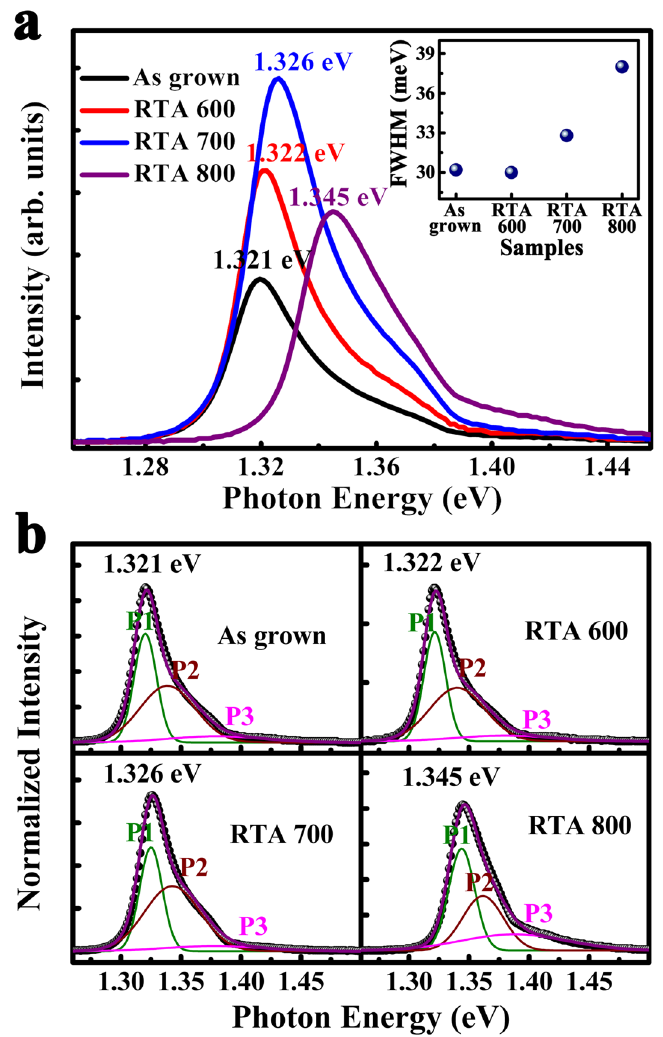
Figure 2. ( a ) The room temperature PL spectra of all MQWs samples. The insert is FWHM of PL spectra. ( b ) The Gaussian fitting results of all room temperature PL spectra for all